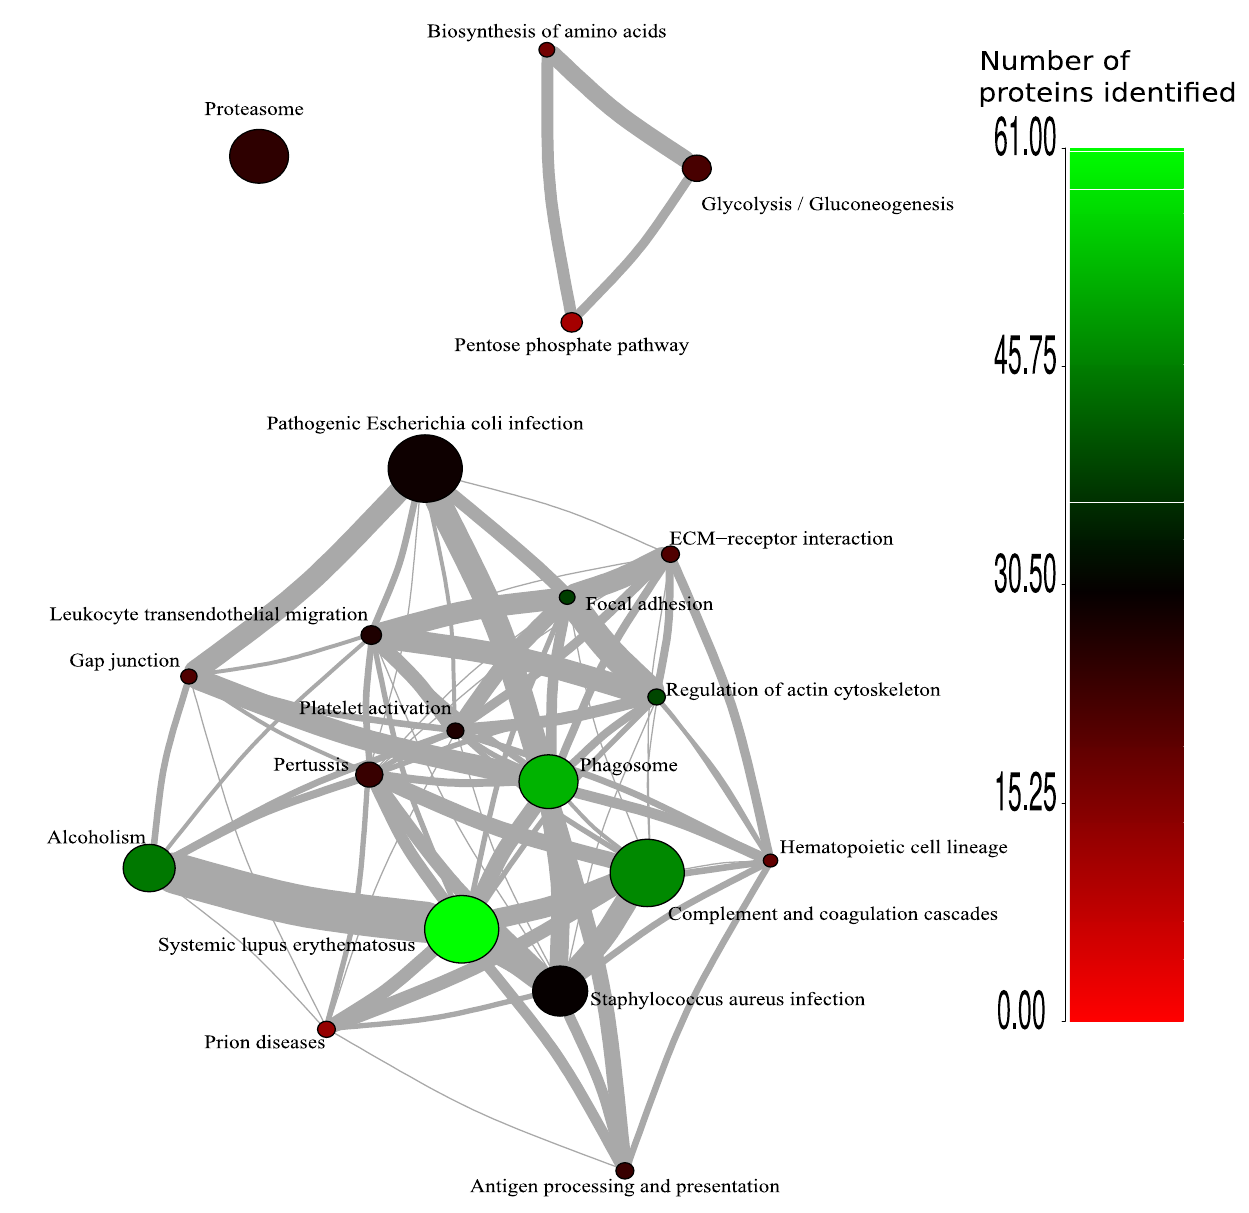
Figure A6. Analysis of overlapping proteins between enriched KEGG pathways for DLBCL. The color coding of the nodes indicates the number of proteins regulated for each category. The size of the nodes reflects − log 10 of enrichment p -value. The thickness of the edges reflects the number of shared regulated proteins between the KEGG pathways (ranging from one to 31 proteins).